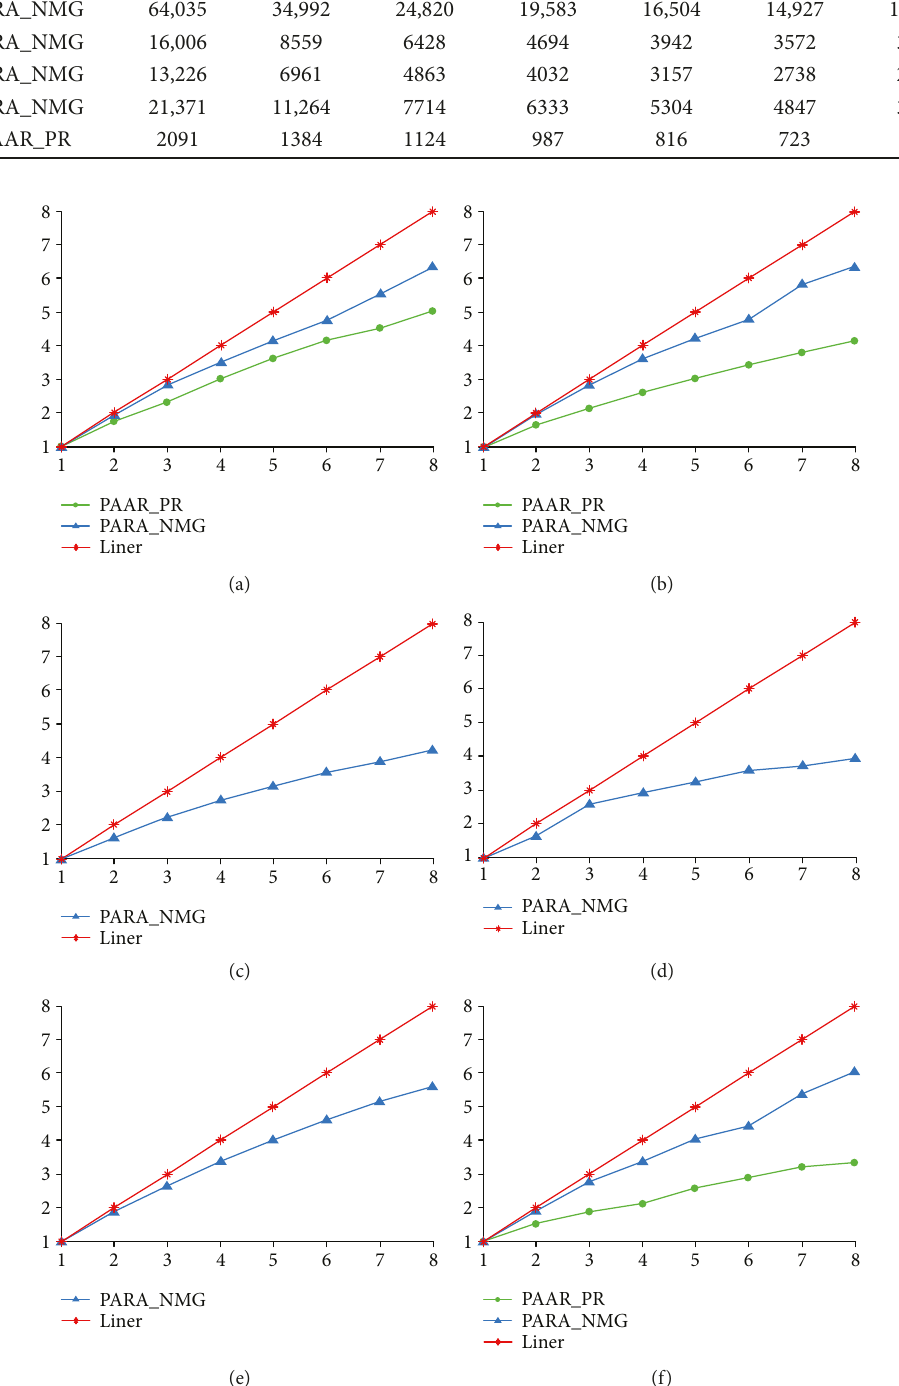
Figure 1: Average speedup on di ff erent number of